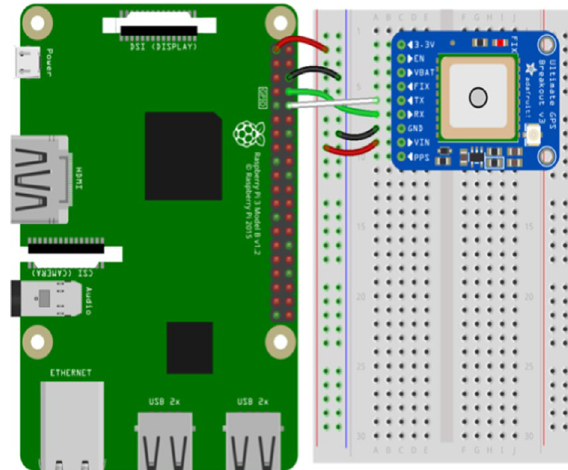
Fig. 11 Circuit diagram of GPS module connecting to Raspberry Pi